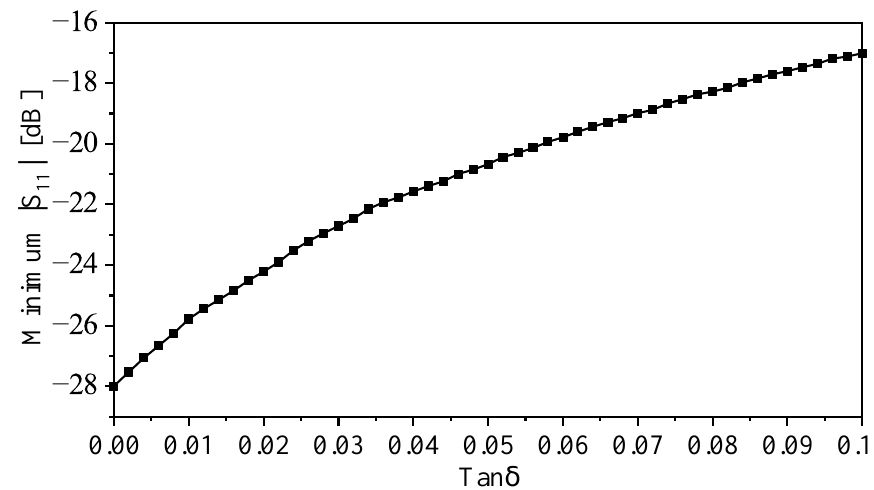
Figure 11. The minimum ( | S 11 | ) versus the loss tangent, in the presence of (cid:101) r = 2.